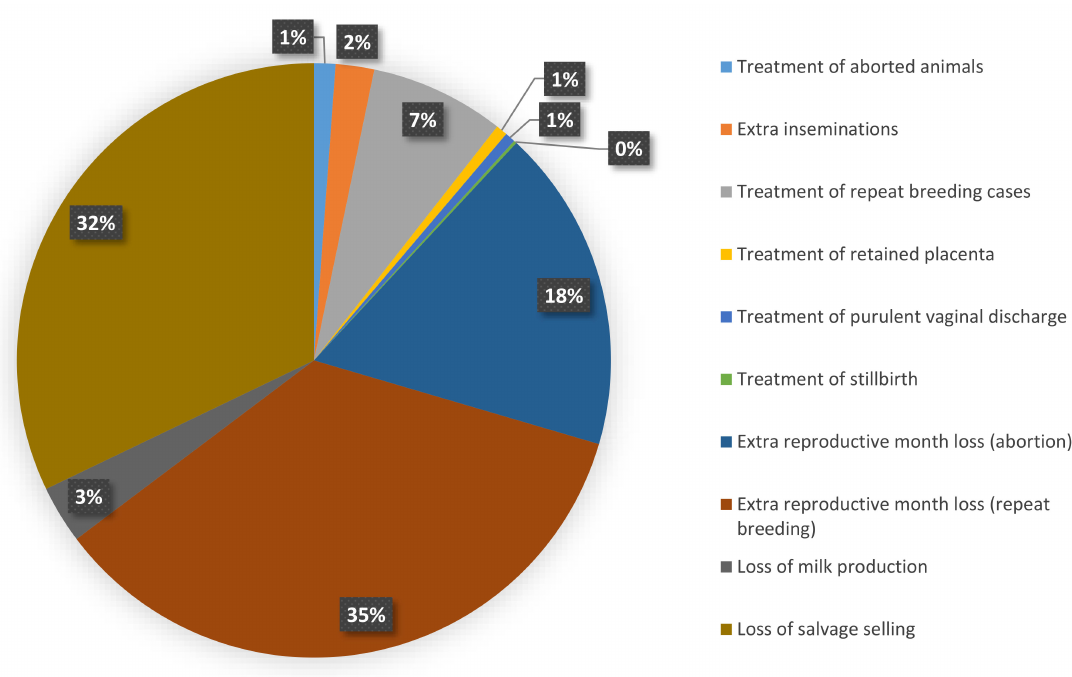
Figure 2. Distribution of different cost components to the total reproductive cost in Bihar. The total cost of reproductive problems in Assam was just 13.0% of the total cost in Bihar. Little more than half (52.4%) of the cost of reproductive problems in Assam was due to indigenous dairy animals, while in Bihar about 61.9% of the cost was due to indigenous dairy